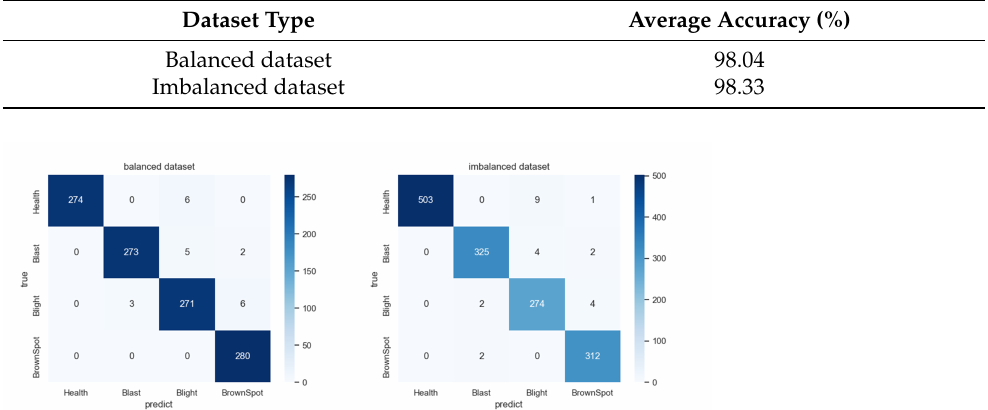
Table 14. The influence of the imbalanced datasets on ResNet-50 testing.